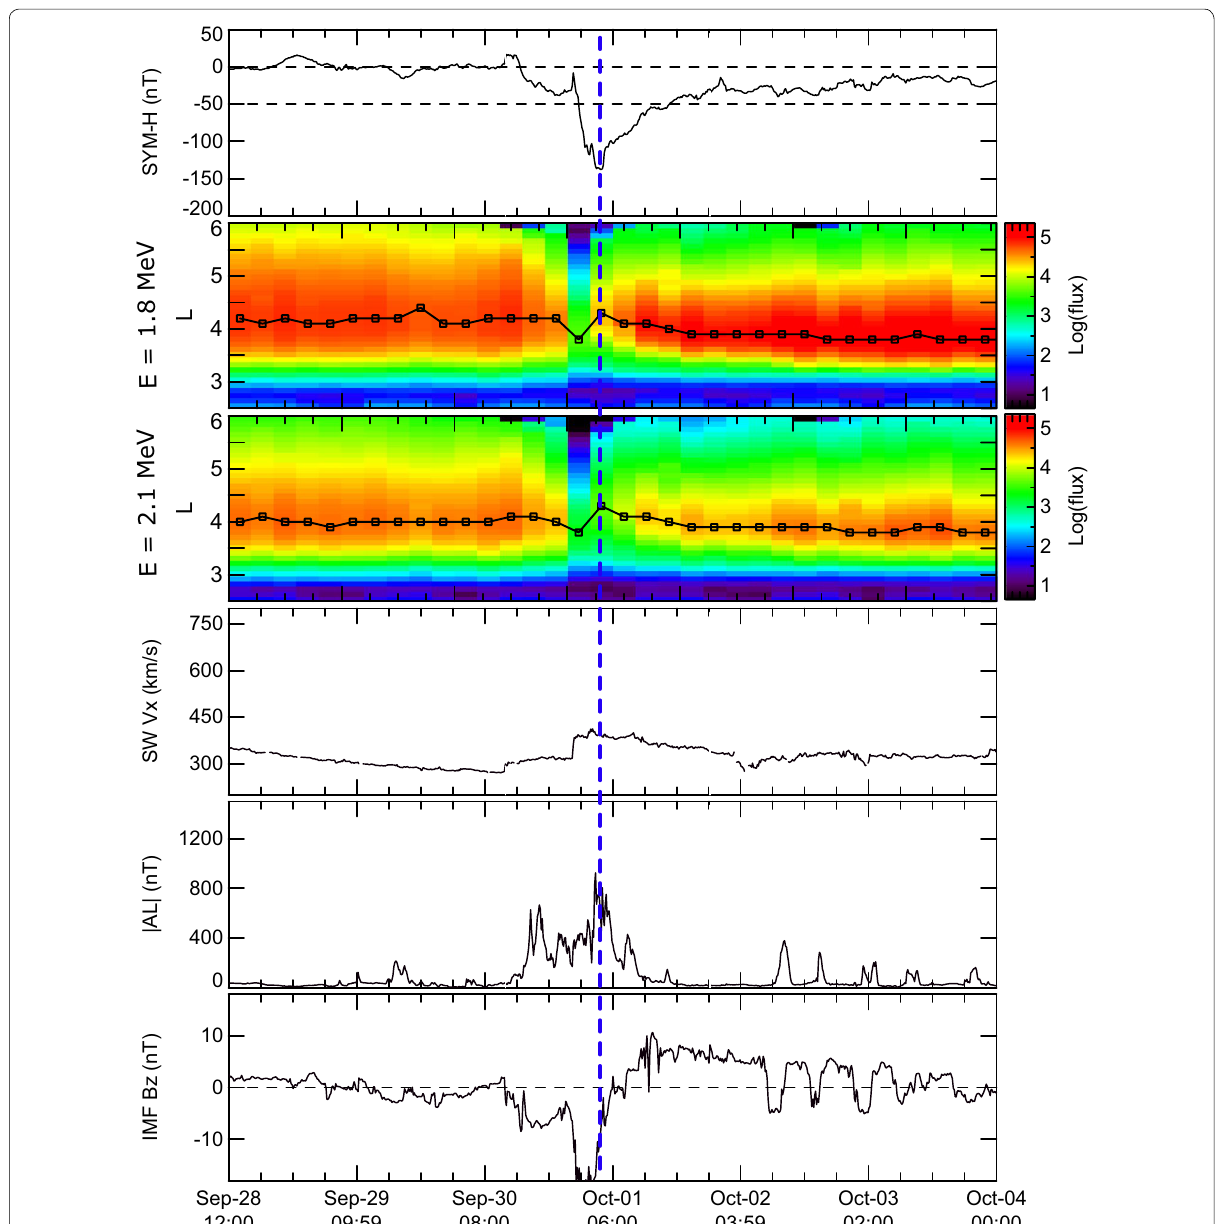
Fig. 3 The same as in Fig. 1 30 September 2012 geomagnetic storm, when ORB fluxes after storm were nearly the